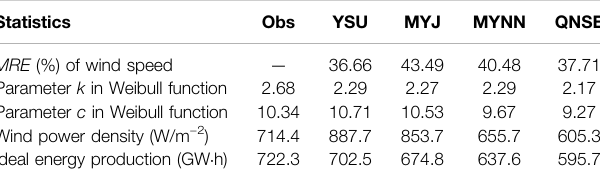
TABLE 1| The MRE ofnear-surfacewind speed,Weibullparameters, wind power density and ideal energy production in observation and simulations. Statistics Obs YSU MYJ MYNN QNSE MRE (%) of wind